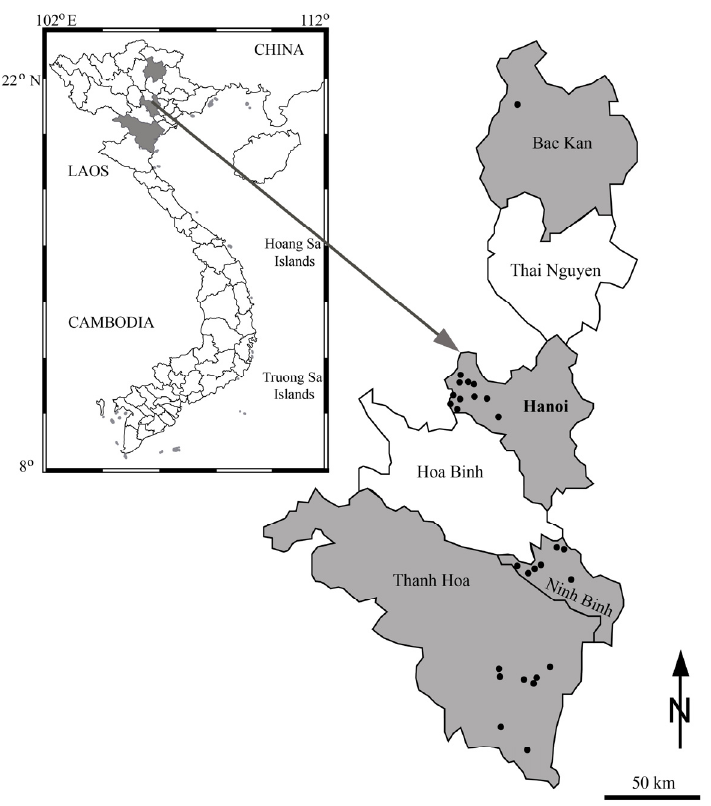
Figure 1. Geographical position of the studied area (dots are sampling areas).